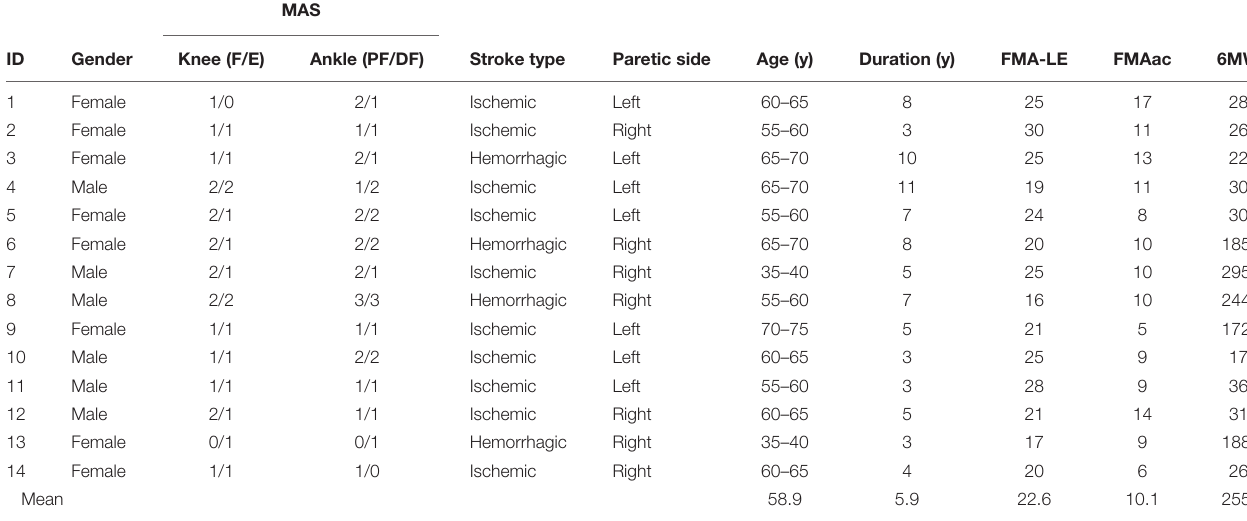
TABLE 1 | Clinical information of